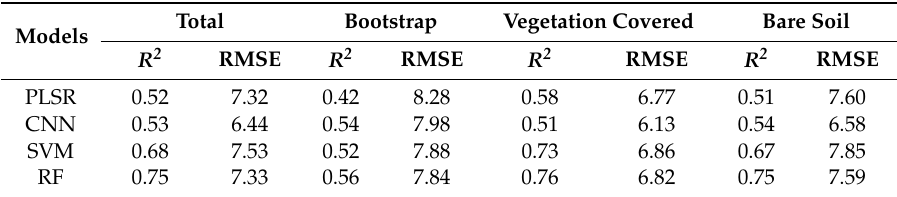
Table 6. Accuracy comparison of partial least squares regression (PLSR), convolutional neural network (CNN), support vector machine (SVM), and random forest (RF)